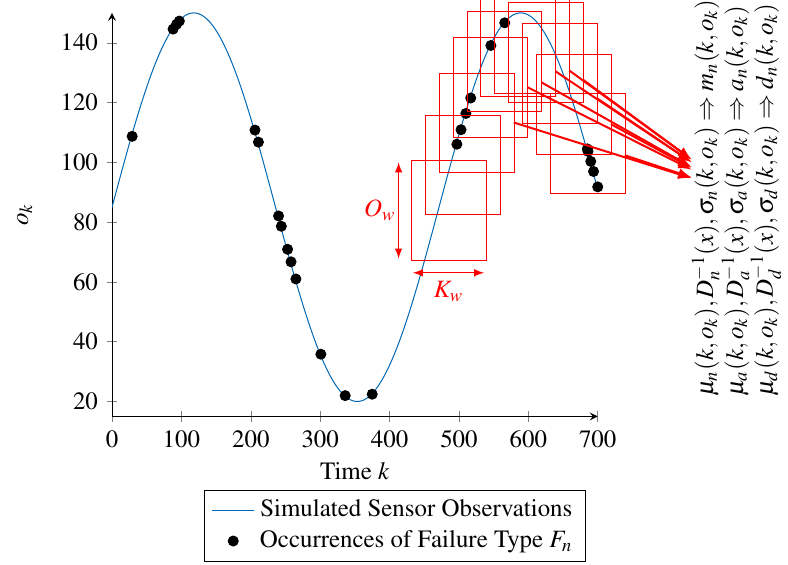
Figure 9. Sliding window approach for identifying time- and value-correlations for a failure type F n P F 2